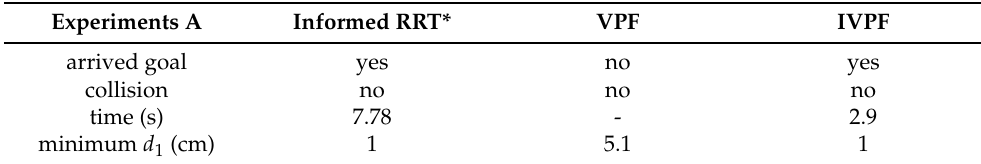
Figure 4. Experiments A: the distance between the robot arm and the target point and obstacles. ( a – c ) The results of the three algorithms. ( a ) informed RRT*; ( b ) VPF; ( c ) IVPF. Table 2. The result of static obstacles avoidance experiment